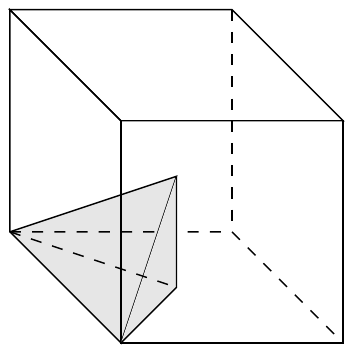
FIG. 2: Each cell of the cubic lattice is sub-divided into 24 Figure 2 . The cubic lattice is divided into tetrahedral cells in our tetrahedra. Only one cubic cell and representative tetrahe- dron are shown.